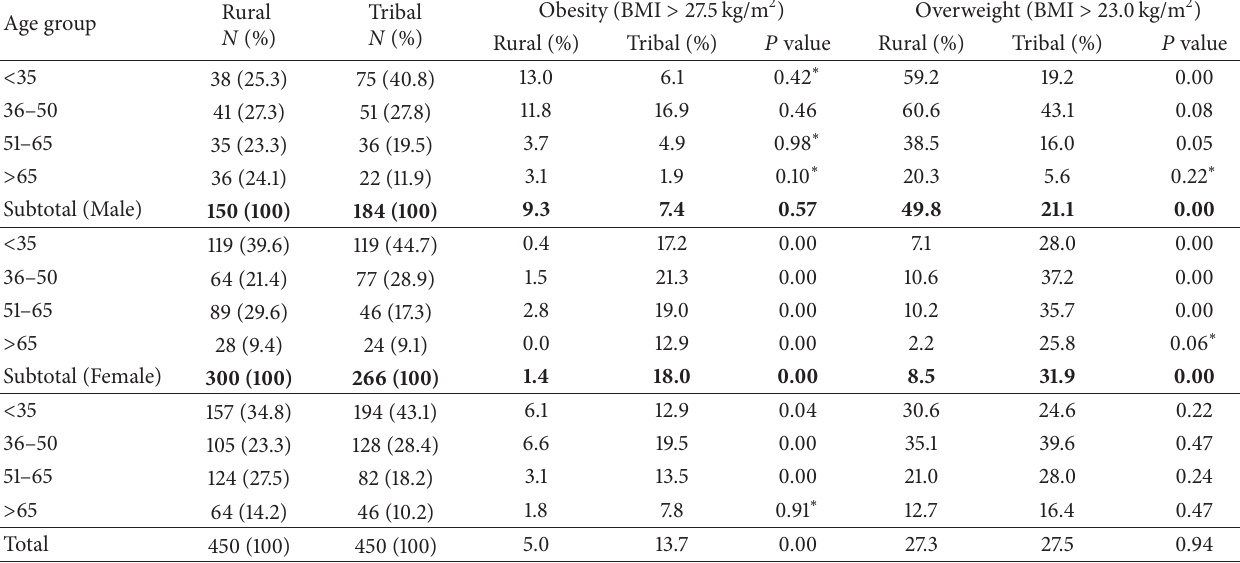
Table 2: Age and sex distribution of body mass index (BMI) in rural and tribal area of a Himalayan state, Himachal Pradesh, India, 2010. Rural Tribal Age group N (%) <